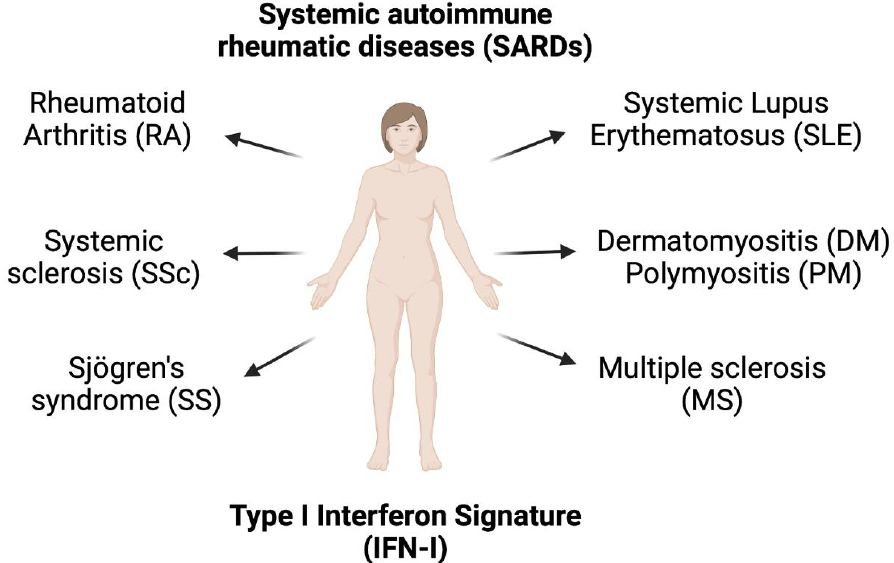
Figure 3. Presence of type I interferon signature in systemic autoimmune rheumatic diseases, which include systemic lupus erythematosus, rheumatoid arthritis, systemic sclerosis, Sjögren’s syndrome, multiple sclerosis, dermatomyositis, and